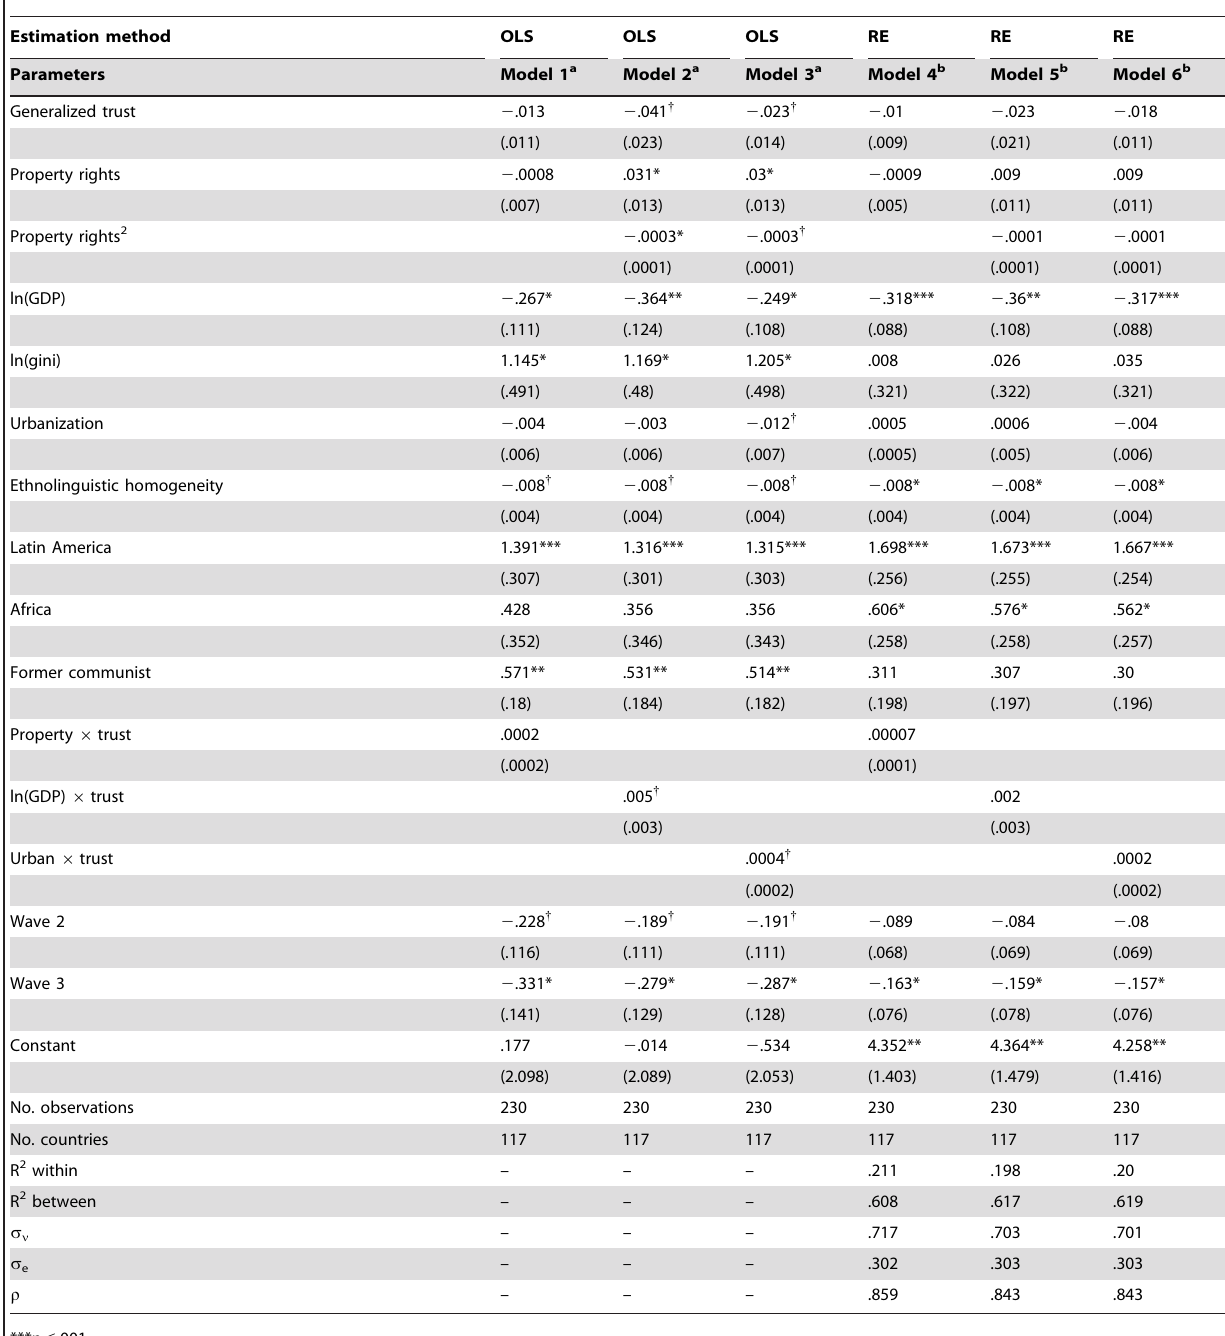
Table 4. Intentional homicide and generalized trust: A pooled time-series conditional